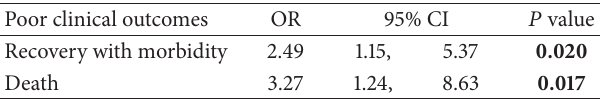
Table 4: Risk (odds ratio and 95% confidence interval) of poor clinical outcomes (recovery with morbidity or death) from sinusitis, classifiedbytypesofsinusitiscomplication,analysedbymultinomial logistic